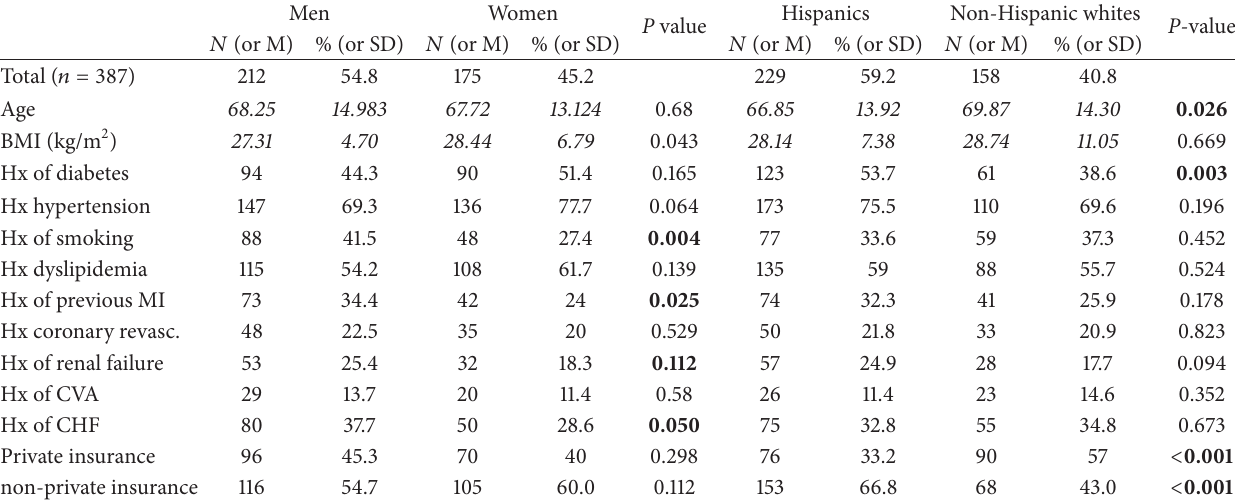
Table 1: Baseline characteristics of patients admitted with acute myocardial infarction (AMI) according to gender and race ethnicity. Men Women Hispanics Non-Hispanic whites P value P -value 𝑁 (or M) % (or SD) 𝑁 (or M) % (or